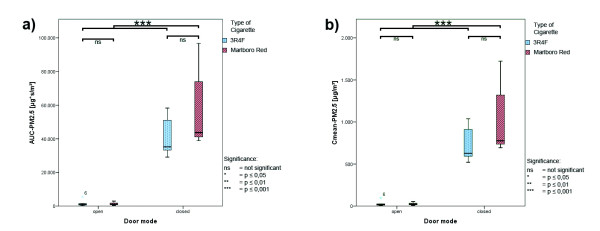
Boxplots of ETS exposure; elimination period. a) AUC-PM2.5; b) Cmean-PM2.5 for 3R4F and Marlboro Red cigarettes; data were analyzed under open- and closed-door conditions.